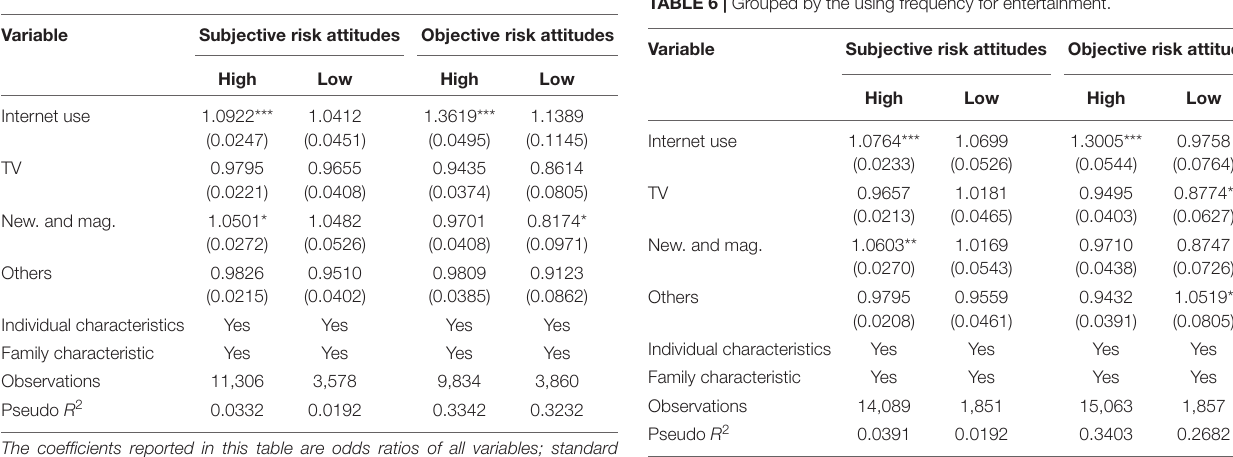
TABLE 4 | Grouped by the using frequency for work.